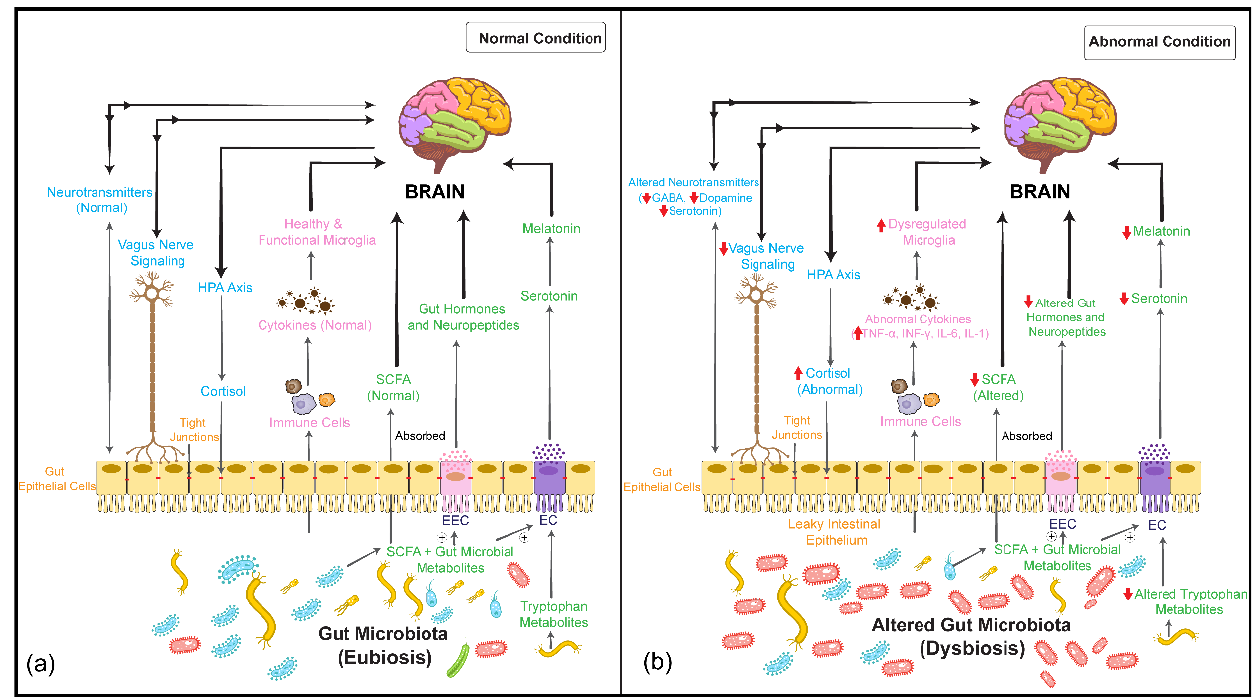
Figure 1. ( a ) Potential pathways involved in the communication between the gut microbiome and brain (microbiota – gut – brain axis, MGBA). ( b ) Alterations in gut microbiome (dysbiosis) and MGBA